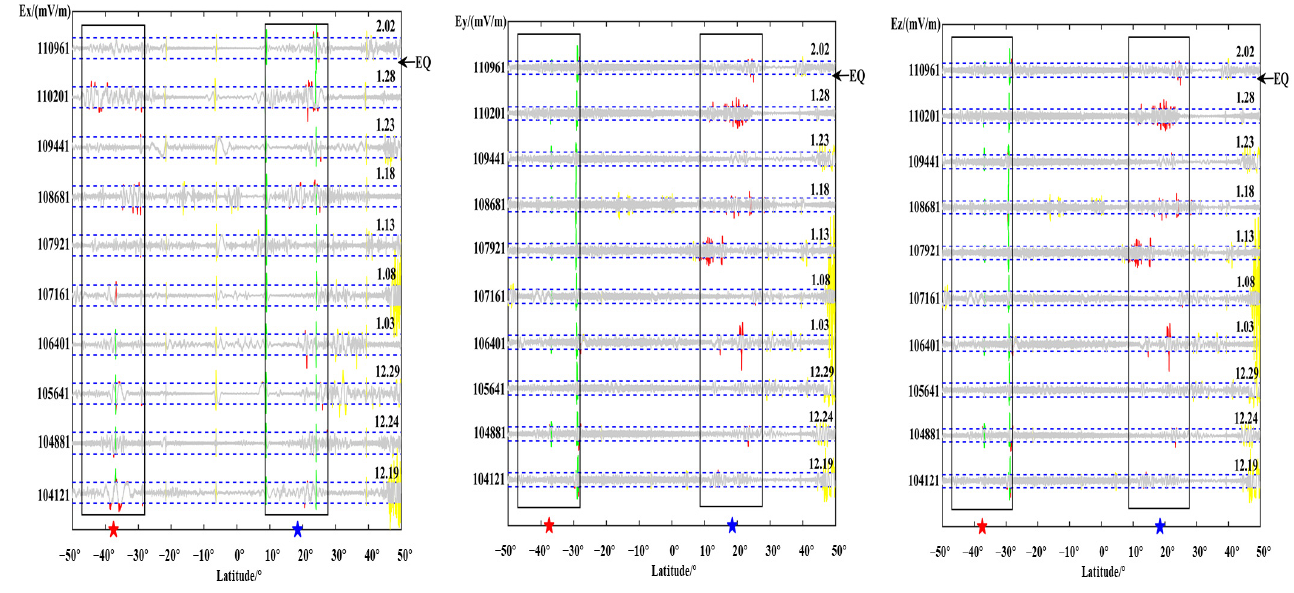
Figure 10. Orbit 110,201 and its revisited tracks.